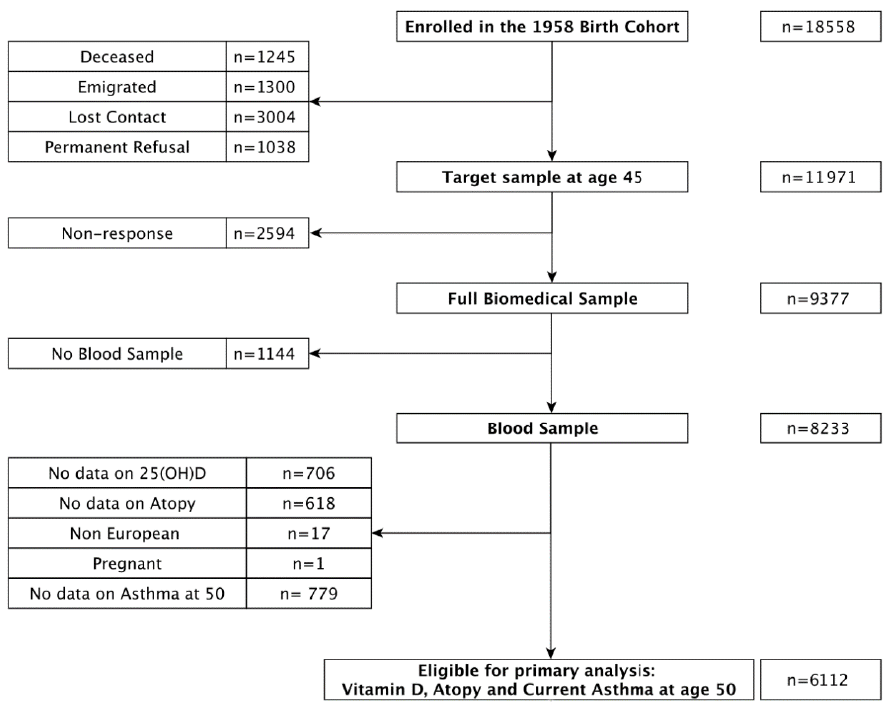
Figure 1. Eligible sample from those that enrolled in the 1958 National Child Development Study.